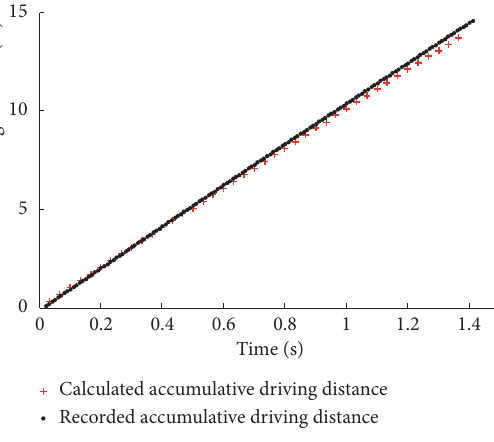
Figure 17: Compared analysis of S and S